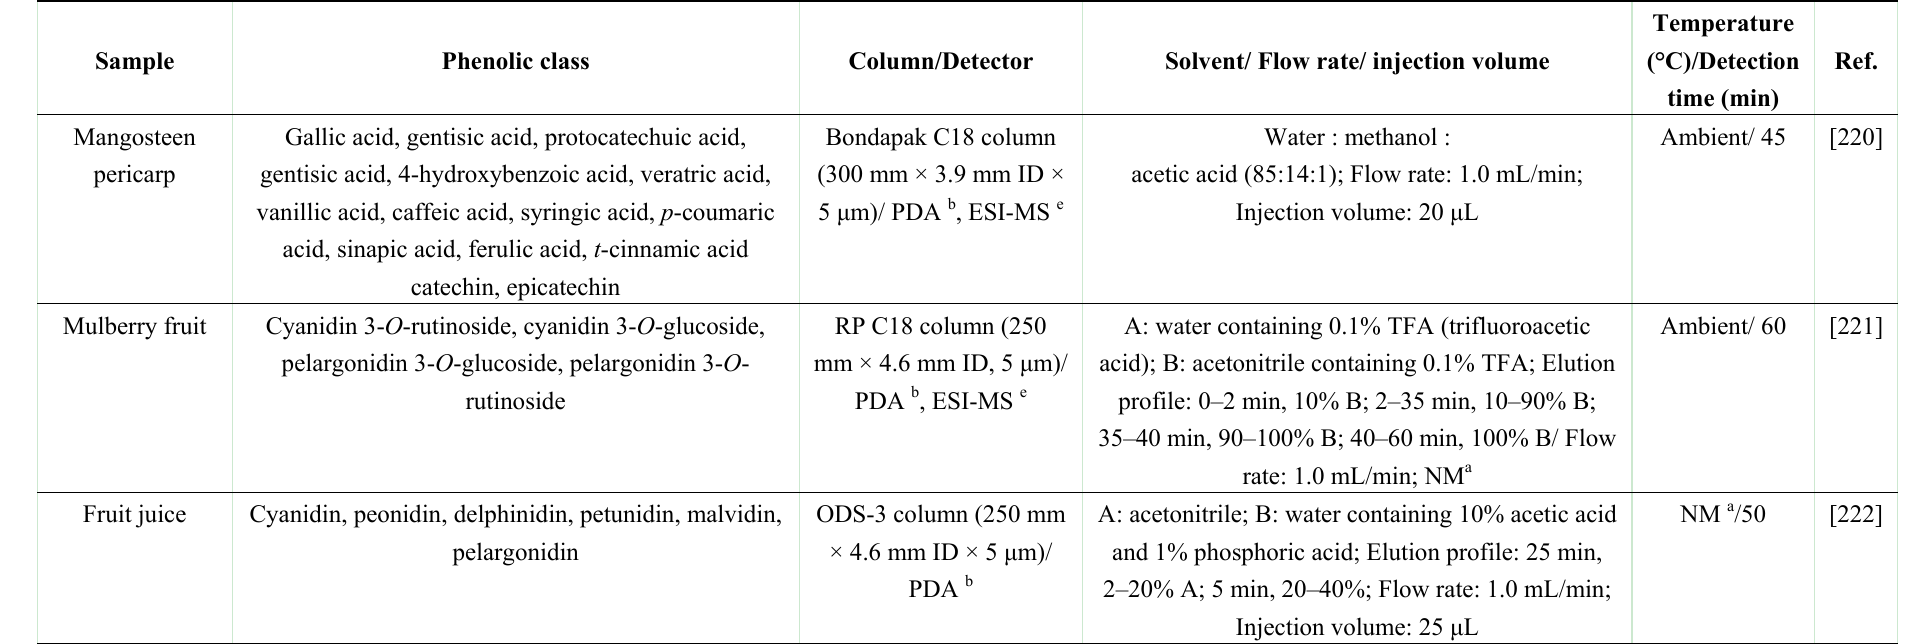
Table 9. Summary of recent HPLC conditions for plant and food phenolic